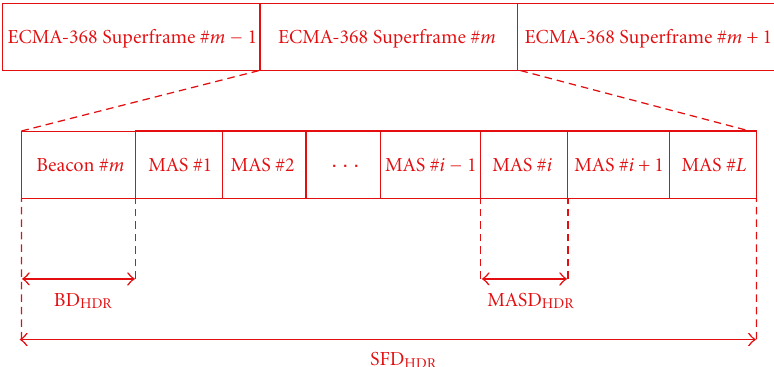
Figure 2: ECMA-368 MAC.